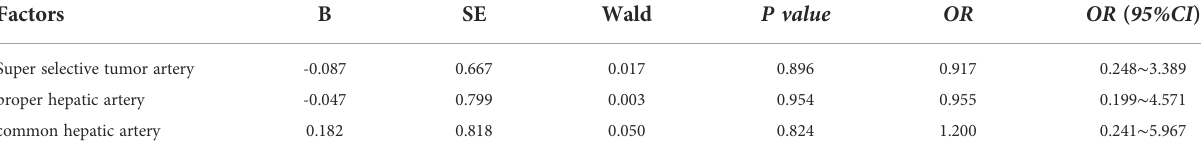
TABLE 8 Binary regression analysis between the injection of Riccatin into arteries and the uniform distribution of Licartin.